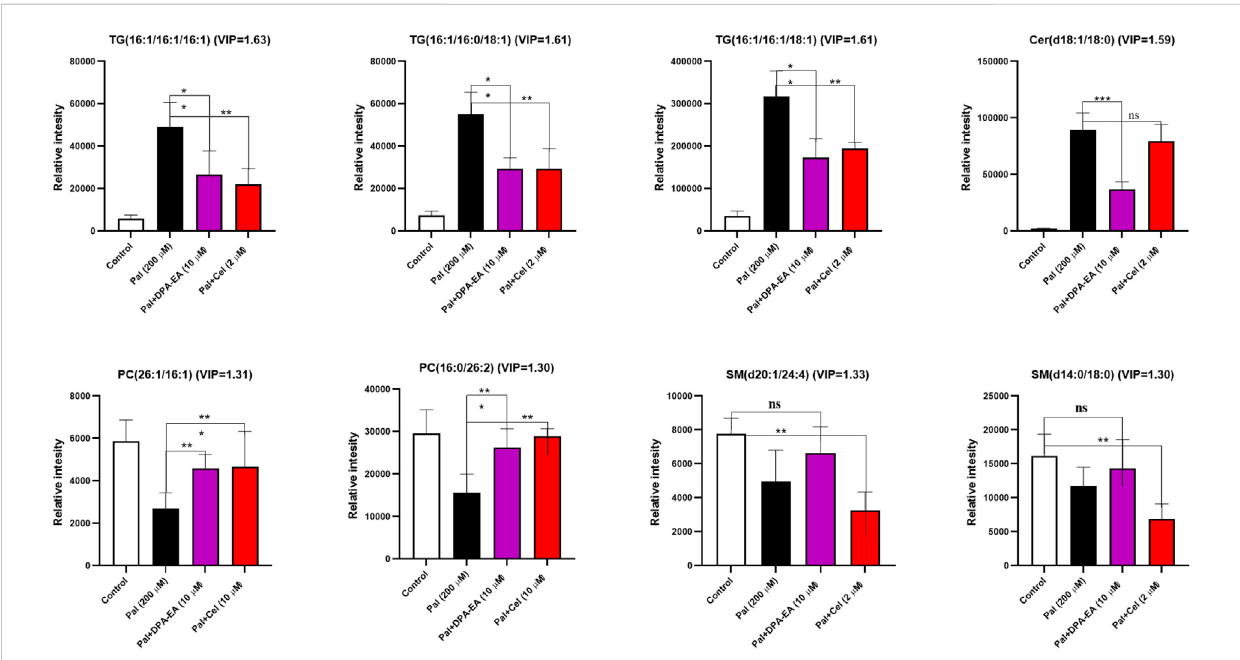
FIGURE 8 Severalpotentiallipidbiomarkers(FC ≥ 2or ≤ 0.5;VIP ≥ 1)inresponsetotheeffectsofDPA-EAandCelastrolonlipidmetabolism.Alldatainthe fi gure are shown as mean ± SD (n ≥ 3). Bars represent the standard deviation from triplicate determinations. Student ’ s t-test was used for the statistical analysis, * p < 0.05 and ** p <